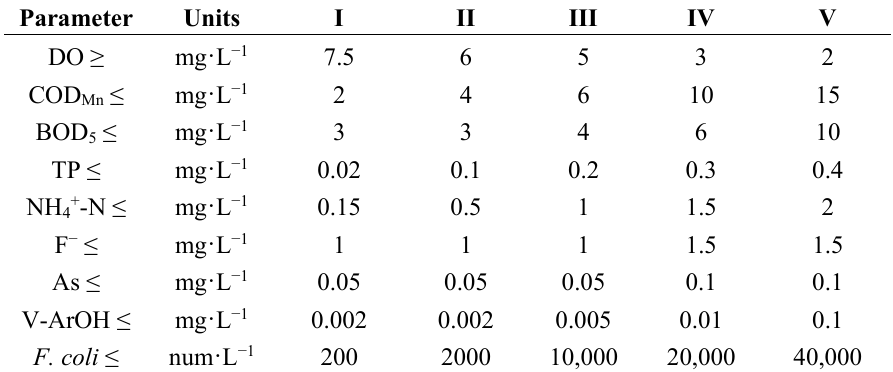
Table 3. Environmental guideline of national quality standards for surface water, China